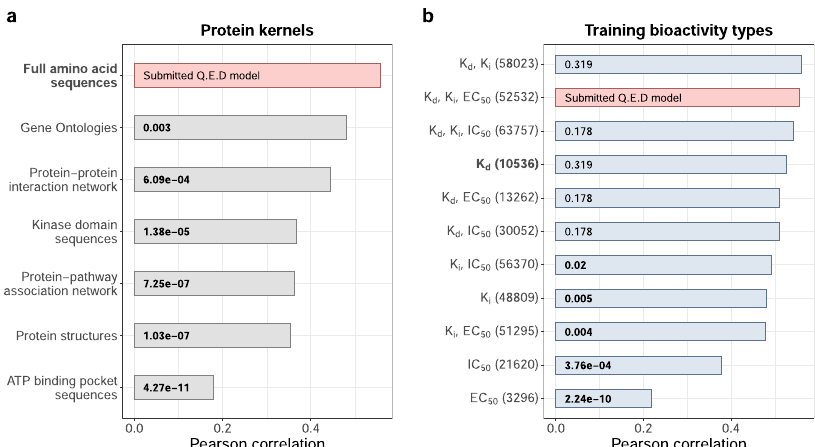
Fig. 6 The effect of protein descriptors and bioactivity types on Q.E.D model accuracy. The bars show Pearson correlations between the measured and Q.E.D model-predicted pK d ’ s calculated over the 394 Round 2 compound-kinase pairs based on different a protein kernels and b training bioactivity data types. The total number of training bioactivity data points is written in parentheses. The original, submitted Q.E.D model based on the full amino acid sequence-based protein kernel and using K d , K i , and EC 50 bioactivities in the training dataset is marked with red. No other changes were introduced to the submitted Q.E.D model, which is an ensemble of the regressors with different regularization hyperparameter values and eight compound kernels, but where each regressor is built upon the same protein kernel based on full amino acid sequences. The protein kernel and training bioactivity type used in the baseline model are marked in boldface. The numbers inside the bars are Benjamini – Hochberg adjusted two-sided P values calculated with the Pearson and Filon test for comparing the correlation of the submitted Q.E.D model and each of its re-trained variants. Since the two correlations under comparison are calculated on the same set of data points and they have one variable in common (measured pK d ), the dependence between pK d ’ s predicted by the submitted Q.E.D model and the new model variant is taken into account in the statistical test. Signi fi cant P values (adjusted P < 0.05) are written in boldface. Source data are provided as a Source Data fi le 54 .